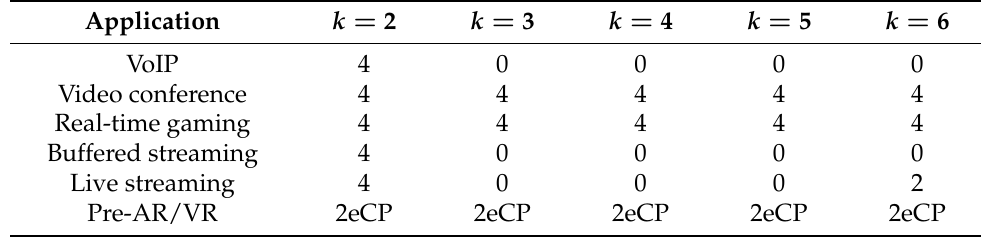
Table 10. Numerology indexes that best meet the application